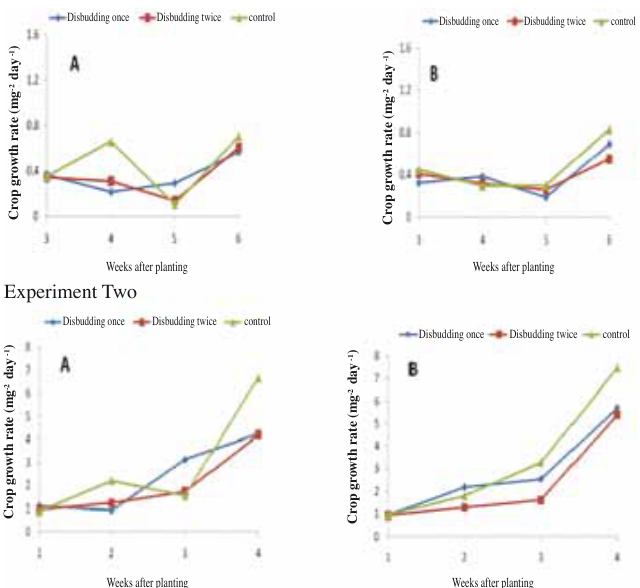
Fig. 1 - Crop growth rate as affected by disbudding and cultivar: ‘Car - mine’ (A) and ‘Chief’ Gold (B).